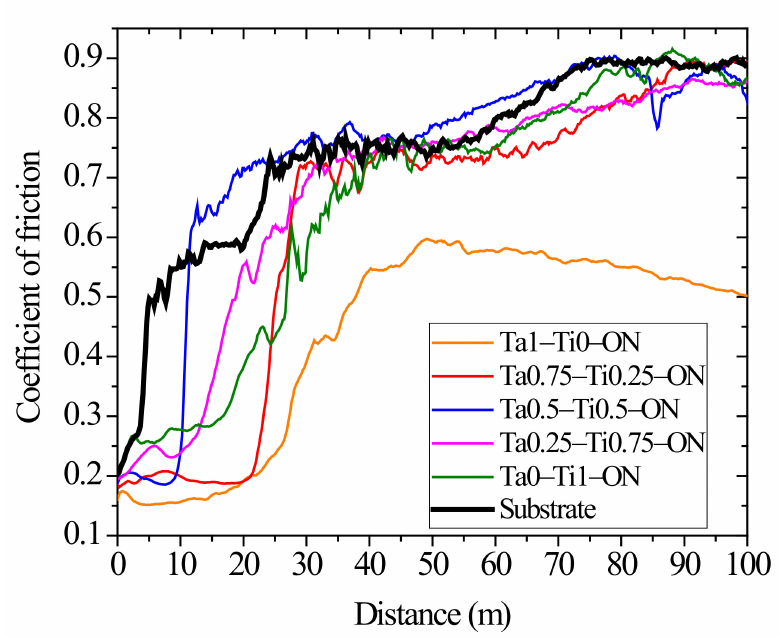
Figure 9. The variation of the friction coefficient as a function of distance.